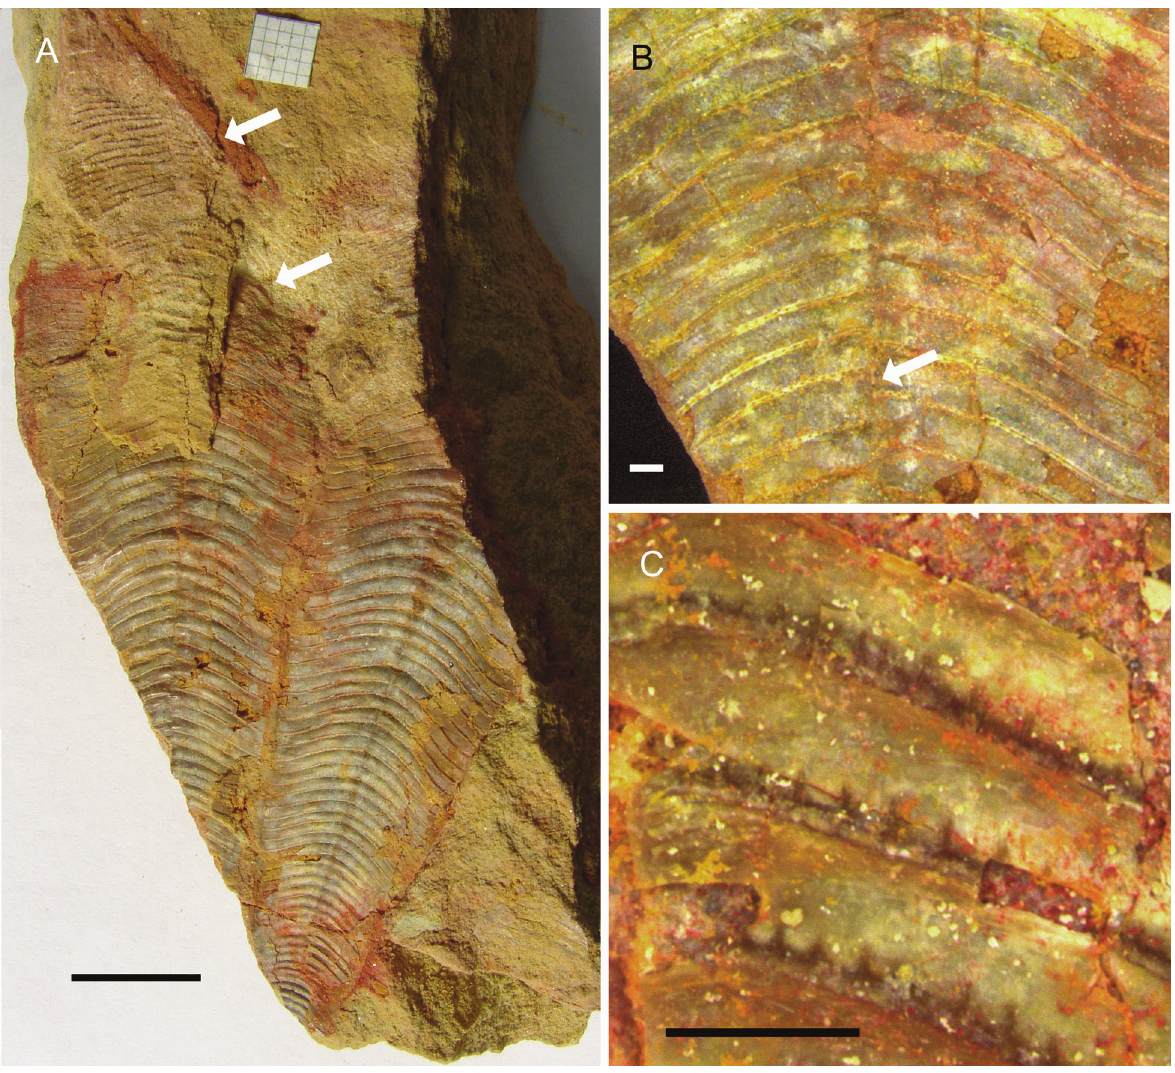
Fig. 3. Conulariid scyphozoan Paraconularia sp. LUGM 290­1015 from the Tērvete Formation, Middle Famennian, Upper Devonian, right bank of the Skujaine River downstream Klūnas settlement, Latvia. The specimen is oriented with the apertural end directed to the top of the page. A , the two exposed faces of the part of the specimen seen in visceral view, and possible lappet in outer view (upper white arrow). The lower white arrow is pointed to the major face. B , part of the major face with the white arrow pointed to the alternation of the transverse ridges. C , detail of the apertural region in the counterpart of the specimen in A, with relatively long spine­like nodes. Scale bars: 1 cm in A, 1 mm in B and